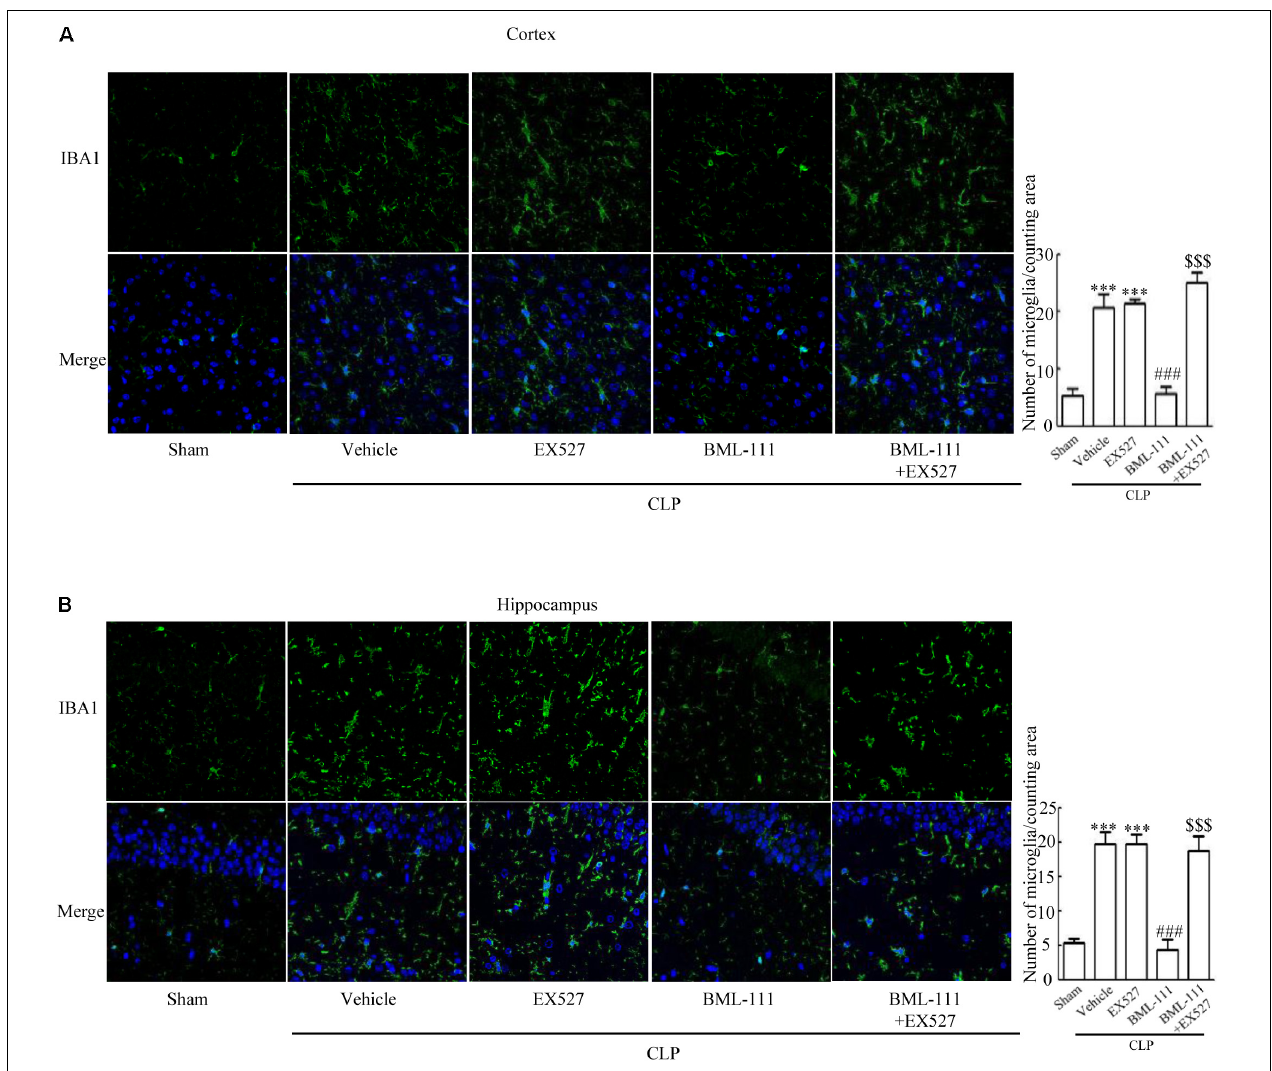
FIGURE 11 | BML-111 decreases the activation of microglia induced via SIRT1 in CLP. (A,B) CLP and EX527 increased the activated microglia compared with sham group, and there did not differ between CLP + Vehicle group and CLP + EX527 group. BML-111 decreased the activated-microglia than in CLP + Vehicle group. EX527 treatment before CLP and BML-111 increased the activated microglia when compared with the CLP + BML-111 group. Scale bars indicate 50 µ m ( n = 3 surviving mice per group). ∗∗∗ P < 0.001 represent CLP + Vehicle vs. Sham and CLP + EX527 vs. sham, ### P < 0.001 represent CLP + BML-111 vs. CLP + Vehicle, $$$ P < 0.001 represent CLP + BML-111 + EX527 vs. CLP +